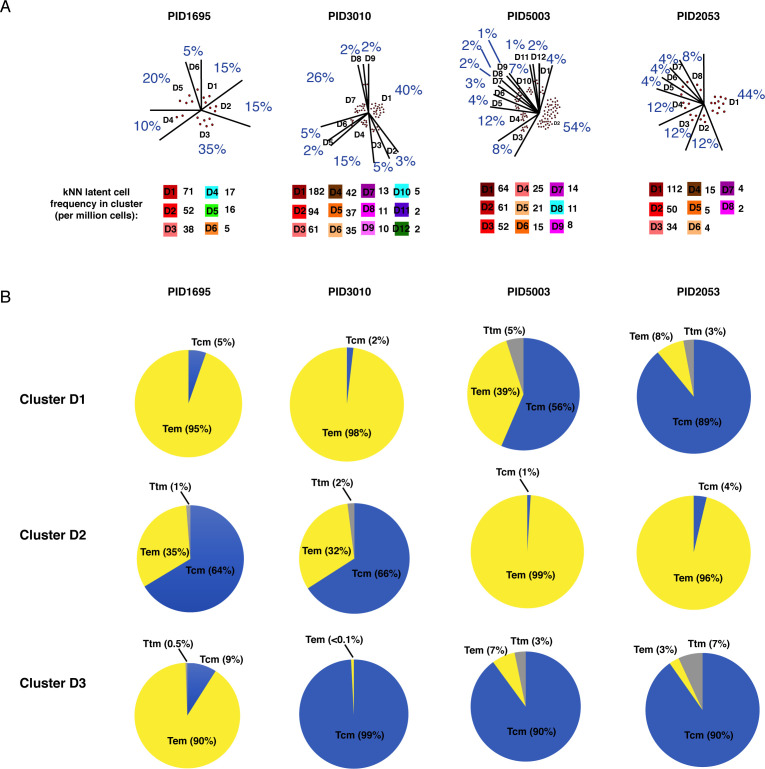
The distribution, frequencies, and phenotypic features of clusters most enriched for kNN latent cells.(A) Top: Shown are the distributions of kNN latent cells among all the FlowSOM ‘D’ clusters in Figure 2D that harbored at least one kNN latent cell, for each of the four participant blood specimens analyzed. Each red circle corresponds to one kNN latent cell, with the total adding up to the number of total kNN cells identified from that specimen. The percentages of kNN latent cells that belong to each of the clusters are indicated in blue. Bottom: Shown are the frequencies of kNN latent cells in each of the FlowSOM clusters that harbored at least one kNN latent cell. For a detailed explanation of how the values in this panel were calculated, see Materials and methods. (B) Shown are the percent of kNN latent cells belonging to the Tcm, Tem, and Ttm subsets for D1-D3, the three clusters in each patient sample harboring the highest frequencies of kNN latent cells.